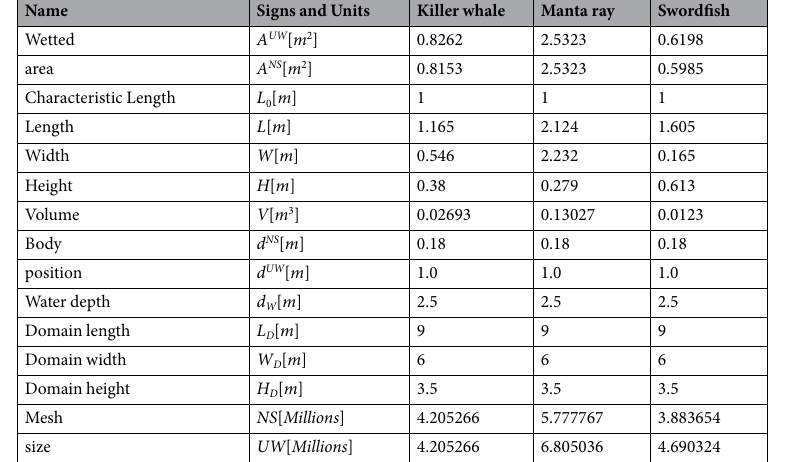
Table 1. Test conditions for the three types of marine animals.